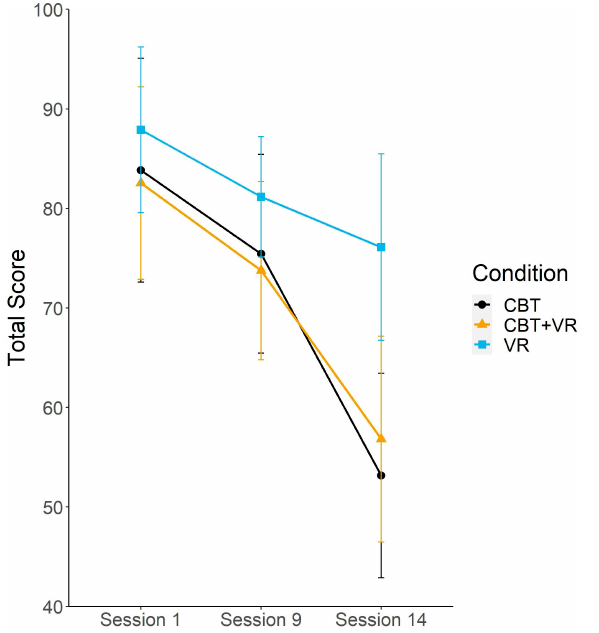
Figure 2. Liebowitz Social Anxiety Scale total score split by condition and measurement time. Error bars represent 95% confidence intervals.